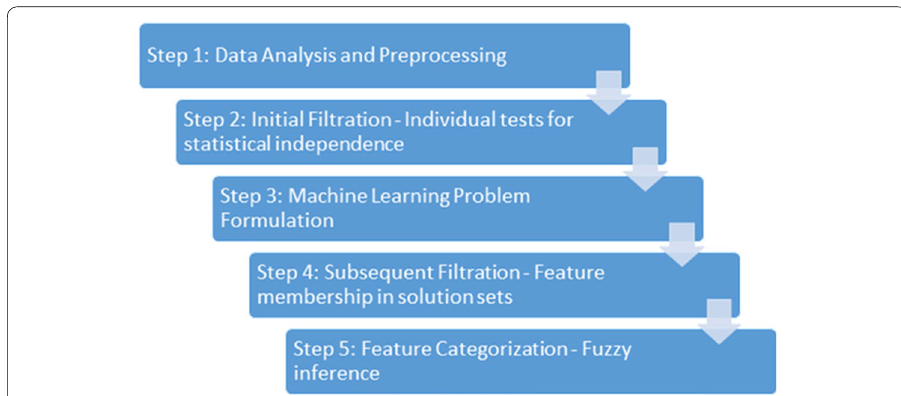
Fig. 5 Proposed framework for data reduction and feature